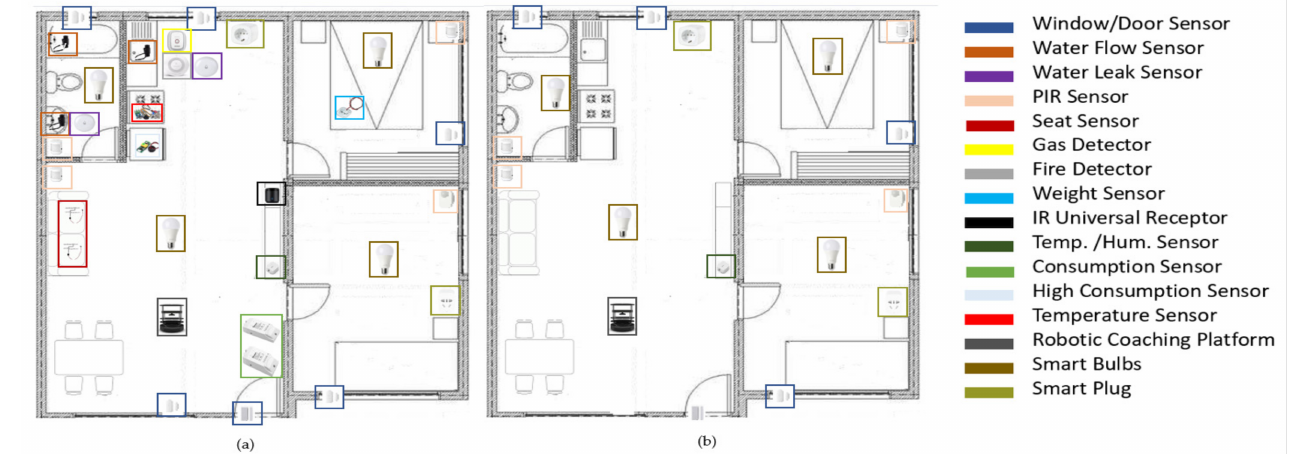
Figure 3. ( a ) Map of proposed elements in the final system. ( b ) Map of test system